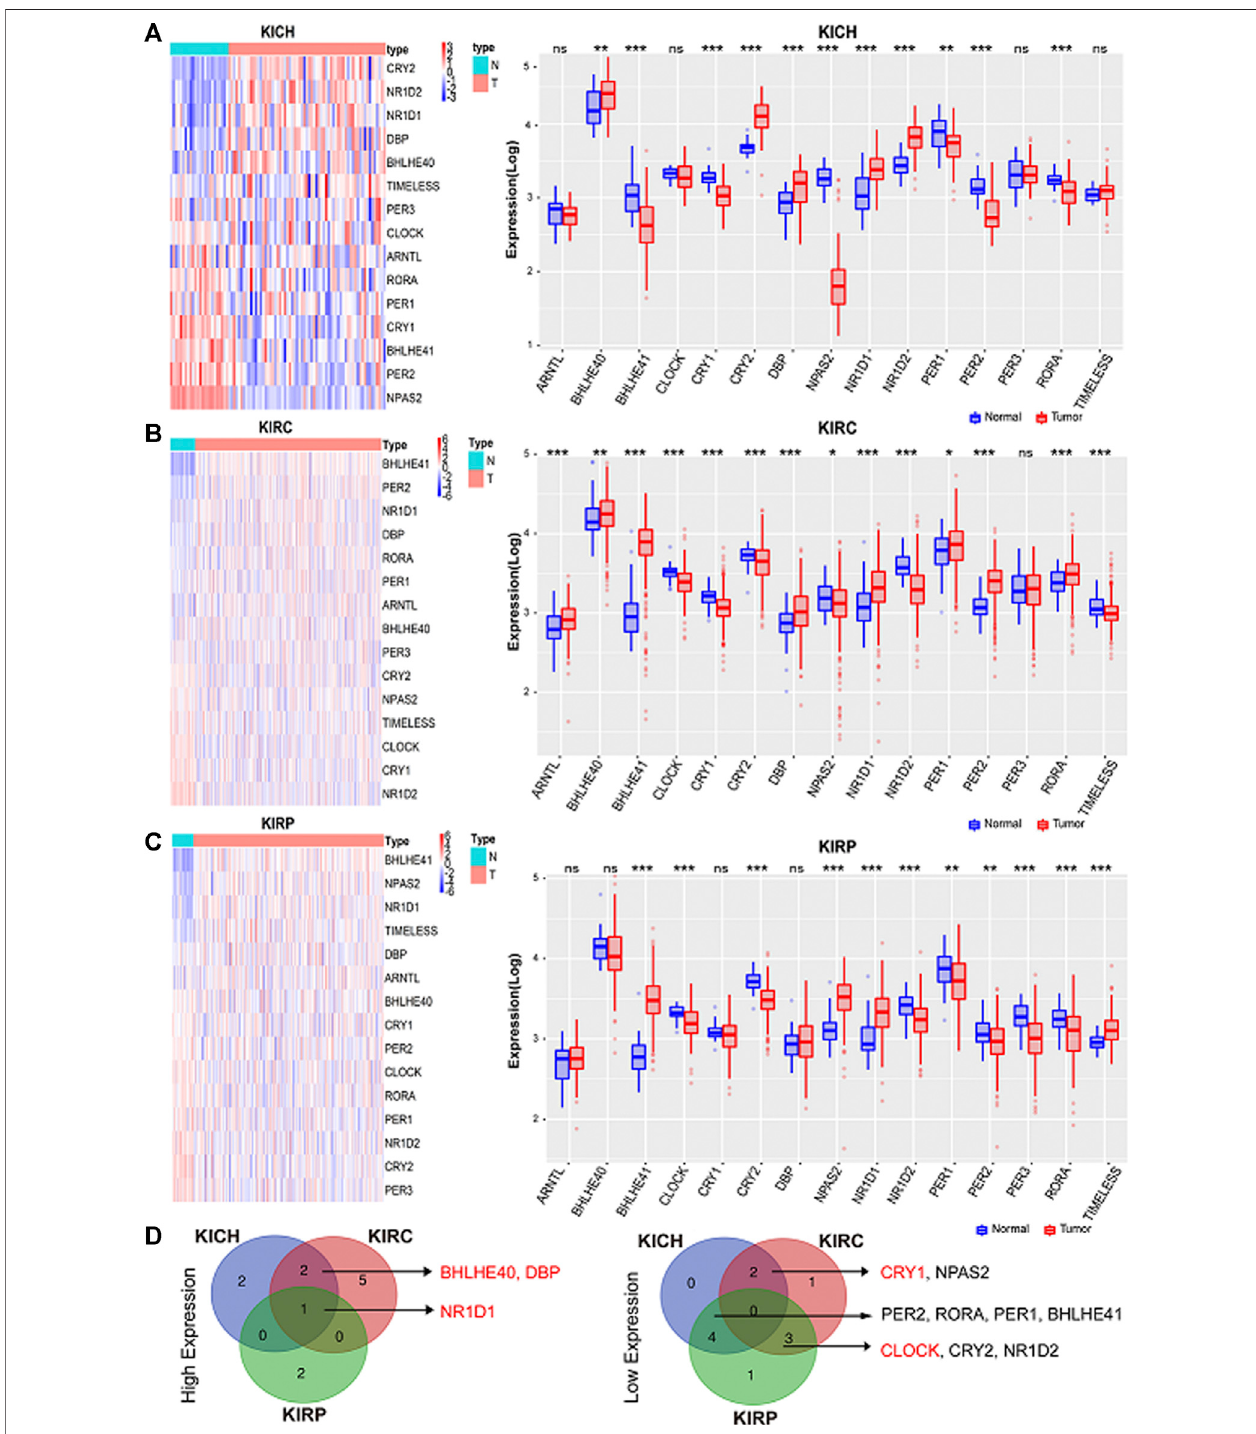
FIGURE2| Corecircadianclockgenesaredysregulatedincancers. (A – C) Expressionpatternsoftheclockcontrolgeneswereshownbyheatmapsandboxplots. Scaledexpressionvaluesintheheatmaparecolor-codedaccordingtothelegendontheright,redrepresentshighexpressionandbluerepresentslowexpression.Here, columns represent patients and rows represent genes, the color bar above the heat map represents the sample groups, and pink indicates cancer tissue, and green represents adjacent normal tissue. The red and blue boxes represent tumor tissues and normal tissues, respectively. * p < 0.05; ** p < 0.001; *** p < 0.001. (D) The intersectionofhighexpressionandlowexpression clockcontrolgenesinpan-RCC.KIRC:Renalclear cellcarcinoma.KICH:Chromophobecellcarcinoma.KIRP:Renal papillary cell carcinoma.